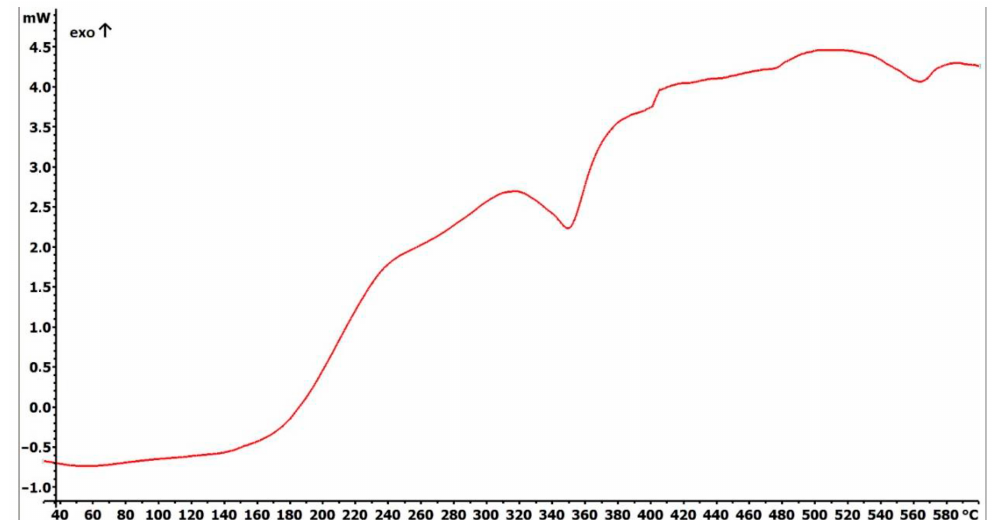
Figure 3. Differential scanning calorimetry (DSC) thermogram of prepared Fe 3 O 4 @SiO 2 -SH nanoparticles.